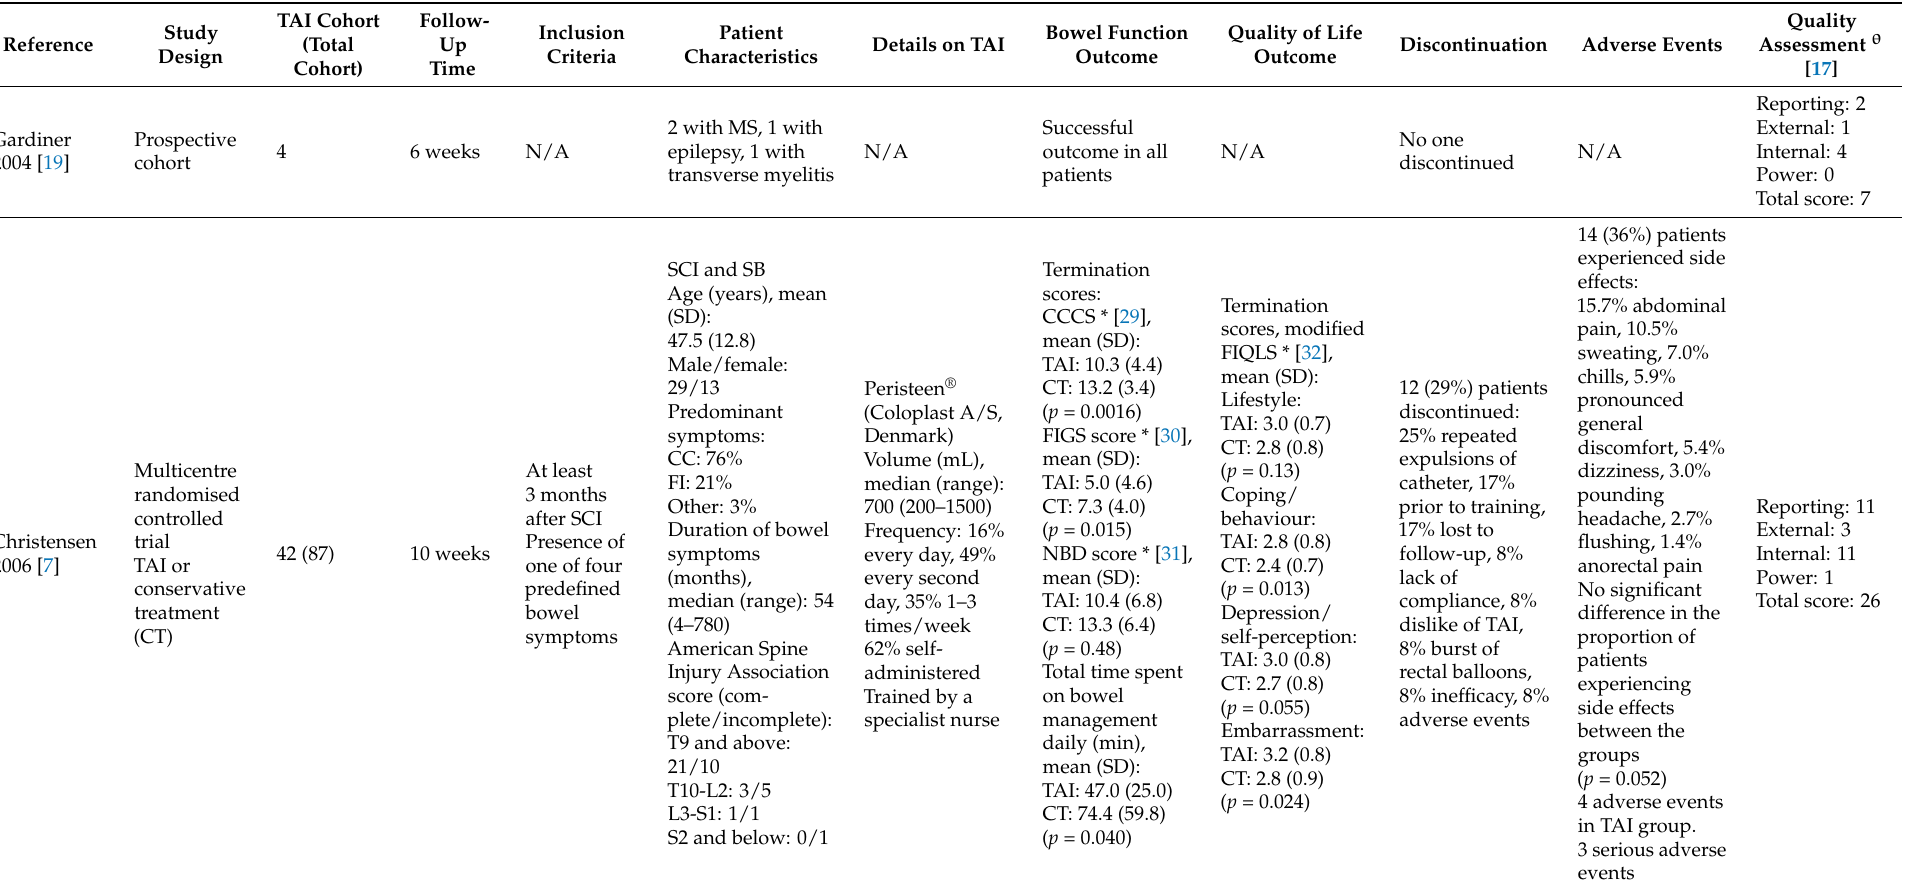
Table 1. Neurogenic bowel